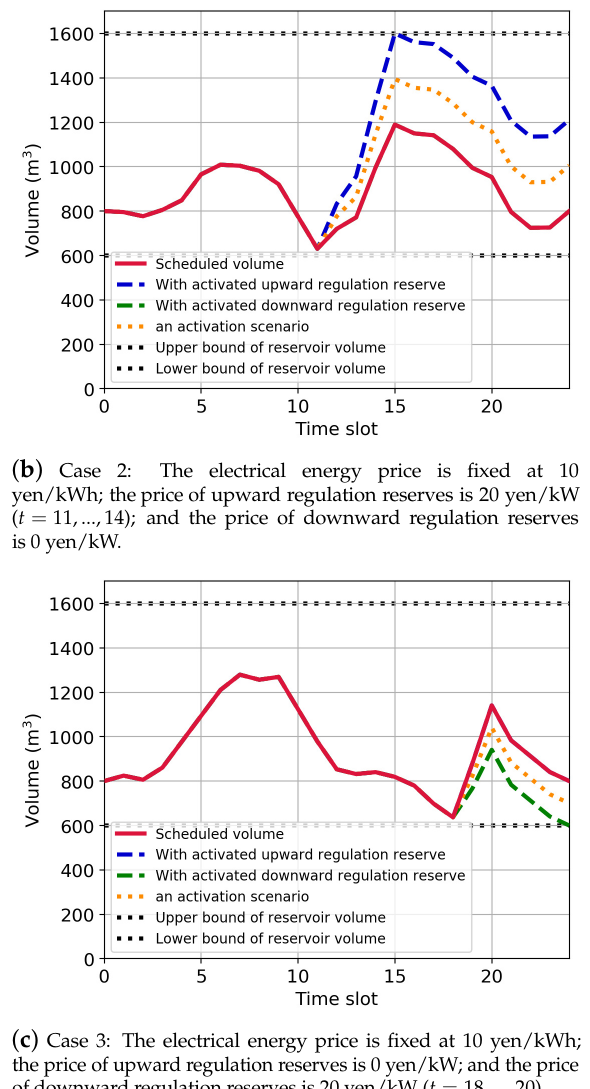
Figure 8. Results for the volume of the reservoir under the fixed electrical energy price. The solid red line shows the planned water storage volume of the reservoir. The blue and green dashed lines show the change in water storage volume when the provided regulation reserve capacities are fully activated. The yellow dotted line represents a changed scenario in the water storage volume when the provided regulation reserves are activated for only half the time in each time